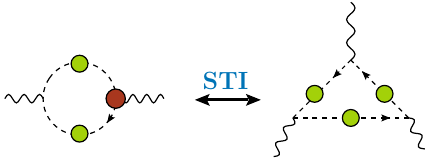
Fig. 4 The ghost loop diagram contributing to the kinetic term J ( q 2 ) , and the ghost triangle diagram entering in the skeleton expansion of three-gluonvertex.BothdiagramsareconnectedbytheSTIofEq.(3.5),